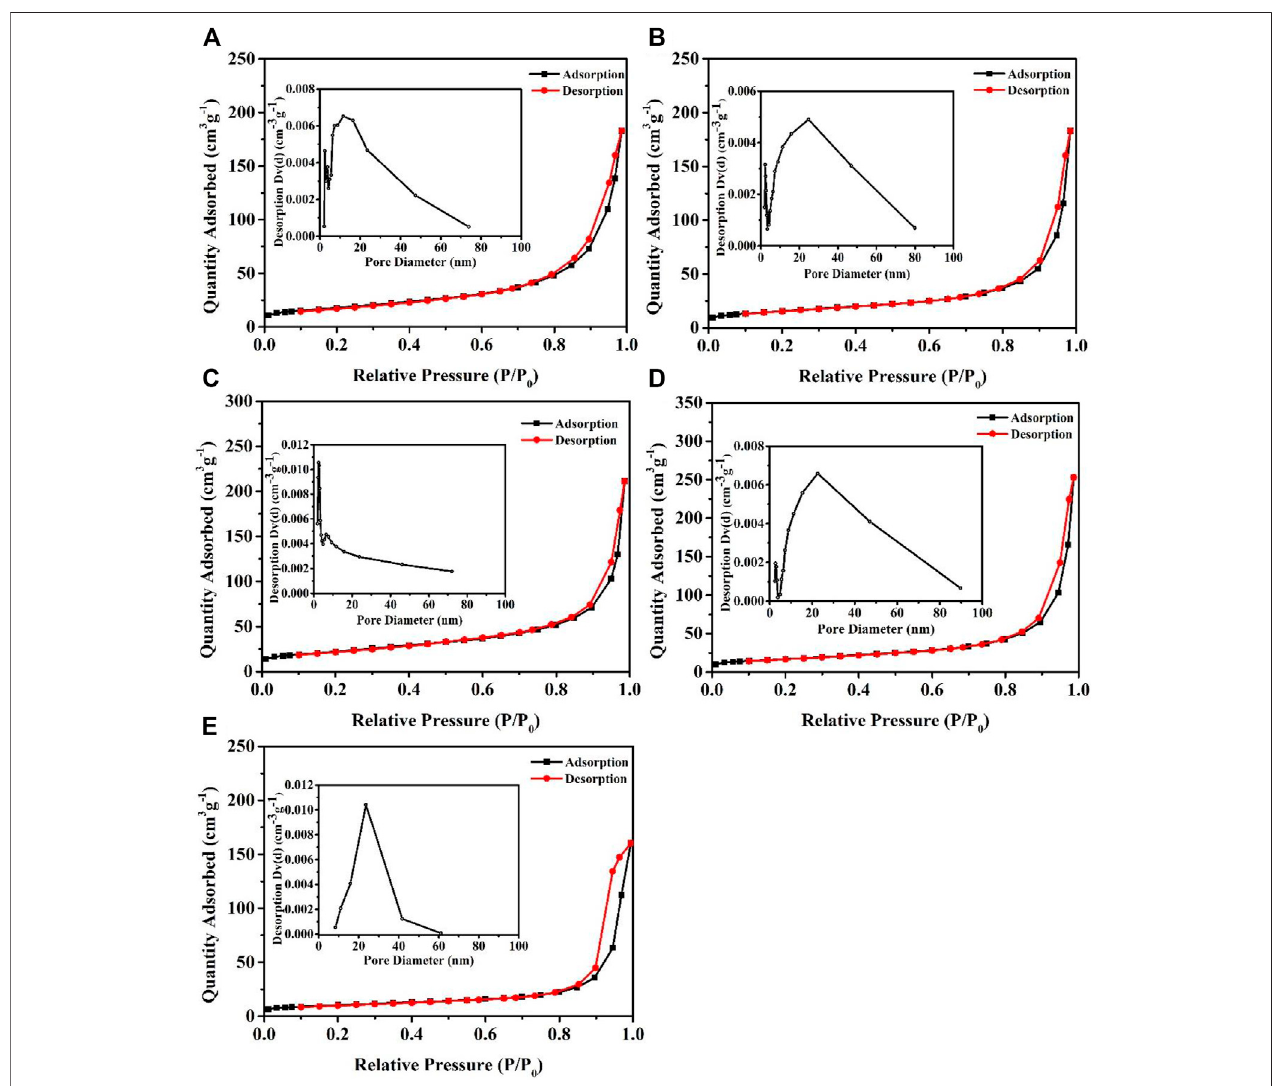
FIGURE 6 | N 2 -adsorption isotherms and pore size distribution (inset) of NiAl-LDHs precursor (A) , the alkaline-etched samples in 5 (B) , 10 (C) , and 15 (D) M KOH solution, and β -Ni (OH) 2 sample prepared by precipitation reaction (E)